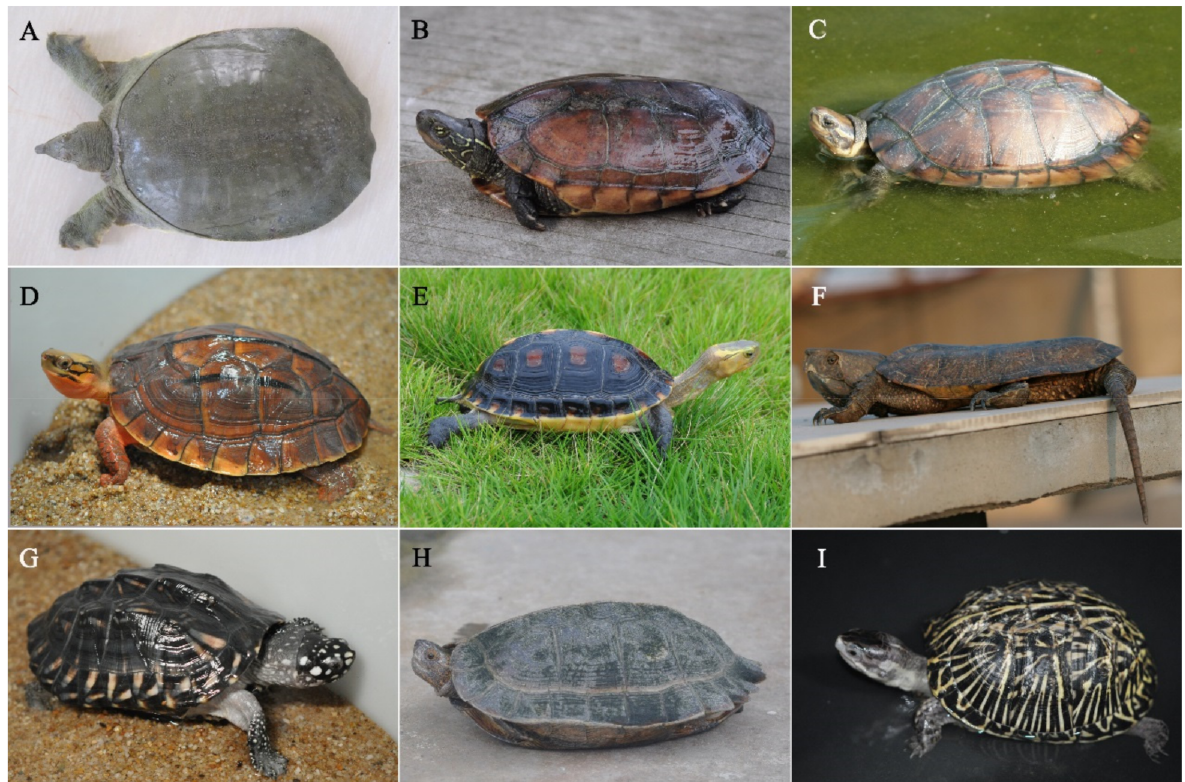
Figure 3. Some turtles domesticated in China. ( A ) Pelodiscus sinensis; ( B ) Chinemys reevesii; ( C ) Mauremys mutica; ( D ) Cuora trifasciata; ( E ) Cuora flavomarginata; ( F ) Platysternon mega- cephalum; ( G ) Geoclemys hamiltonii; ( H ) Heosemys grandis; ( I ) Terrapene Carolina.